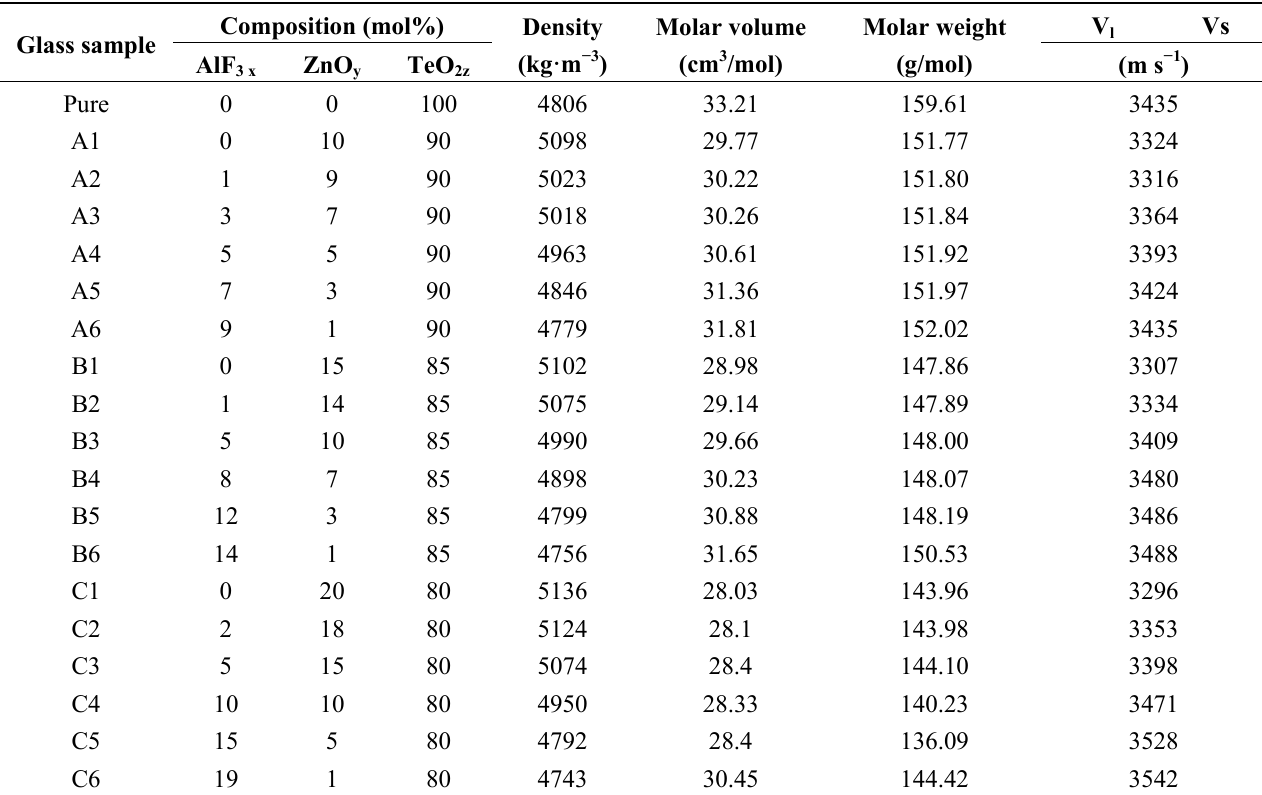
Table 1. Glass composition, density, molar volume, molecular weight, longitudinal and shear ultrasonic wave velocities of (AlF included for